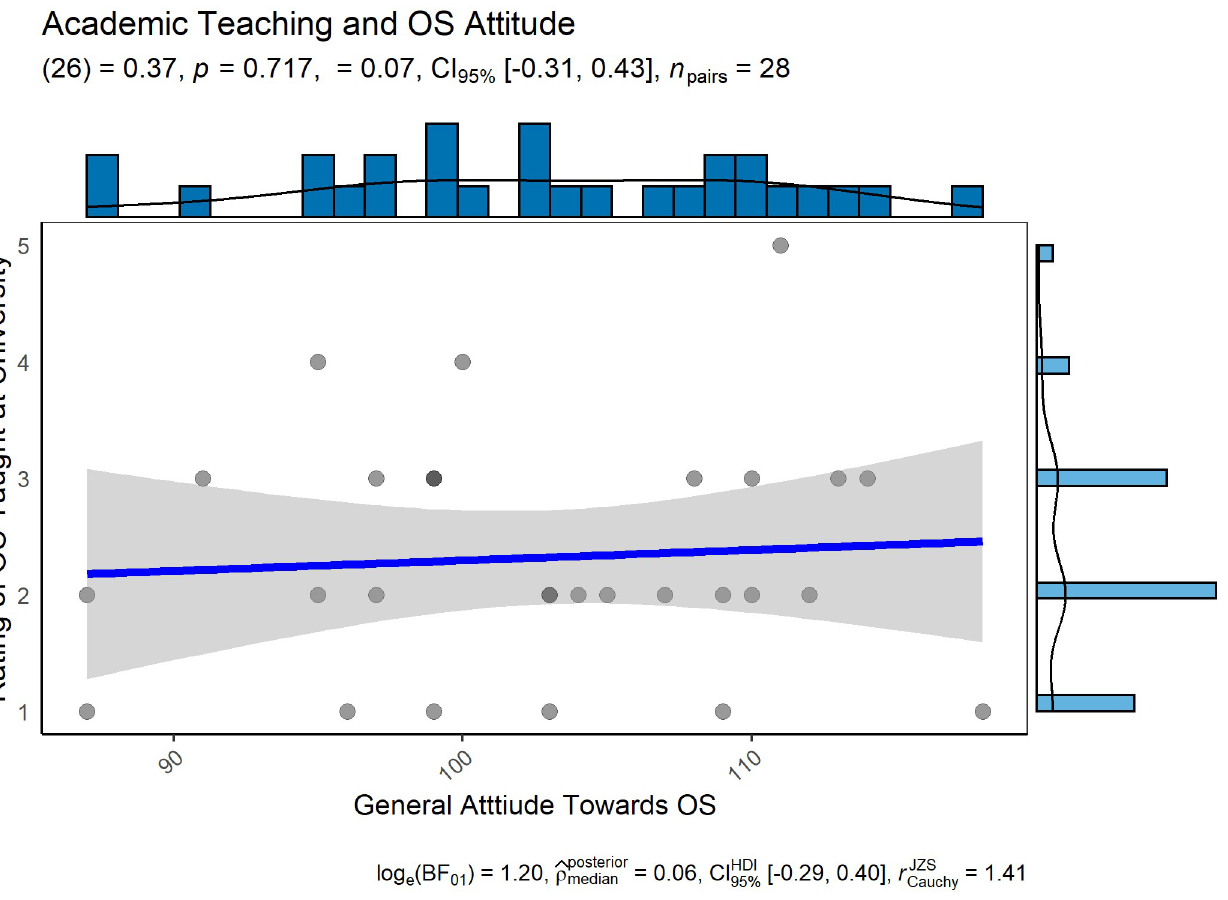
Fig 3. Correlation of OS being taught at university to participants’ attitude towards OS. A positive correlation displays more positive attitudes towards OS when present as part of the